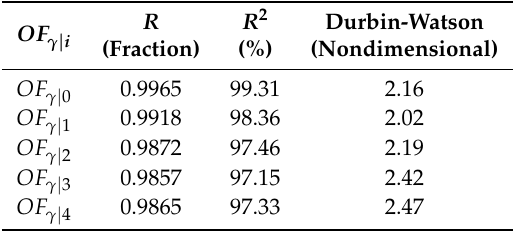
Table 1. Statistics for the objective function OF γ | i (linear regressions in Figure